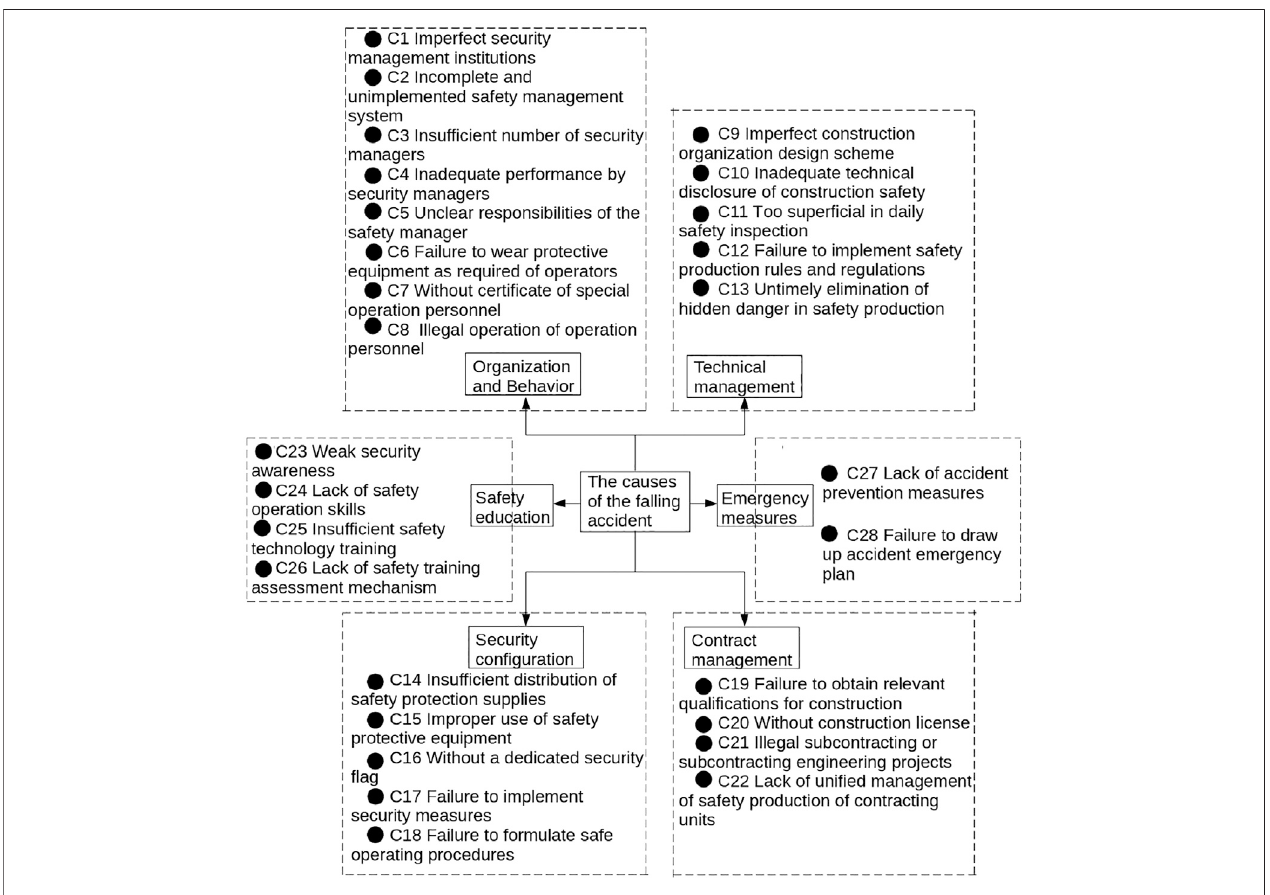
FIGURE 3 | Causal factors of construction site fall accidents.